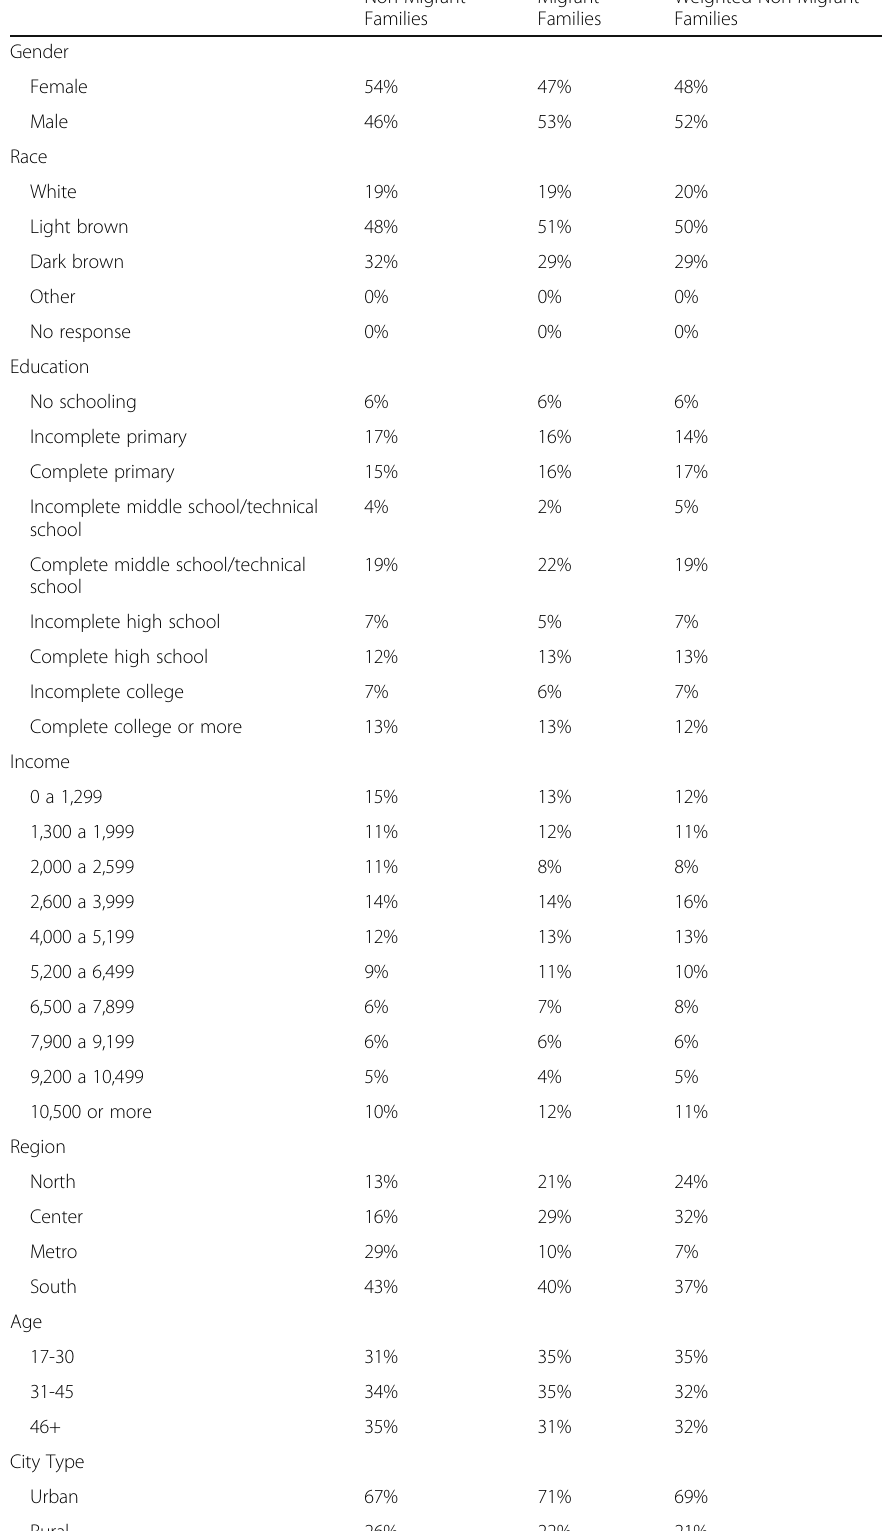
Table 1 Distribution of Selected Characteristics by Migration Treatment and Control